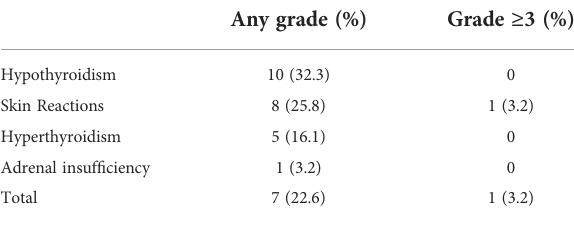
TABLE 3 Immune-related